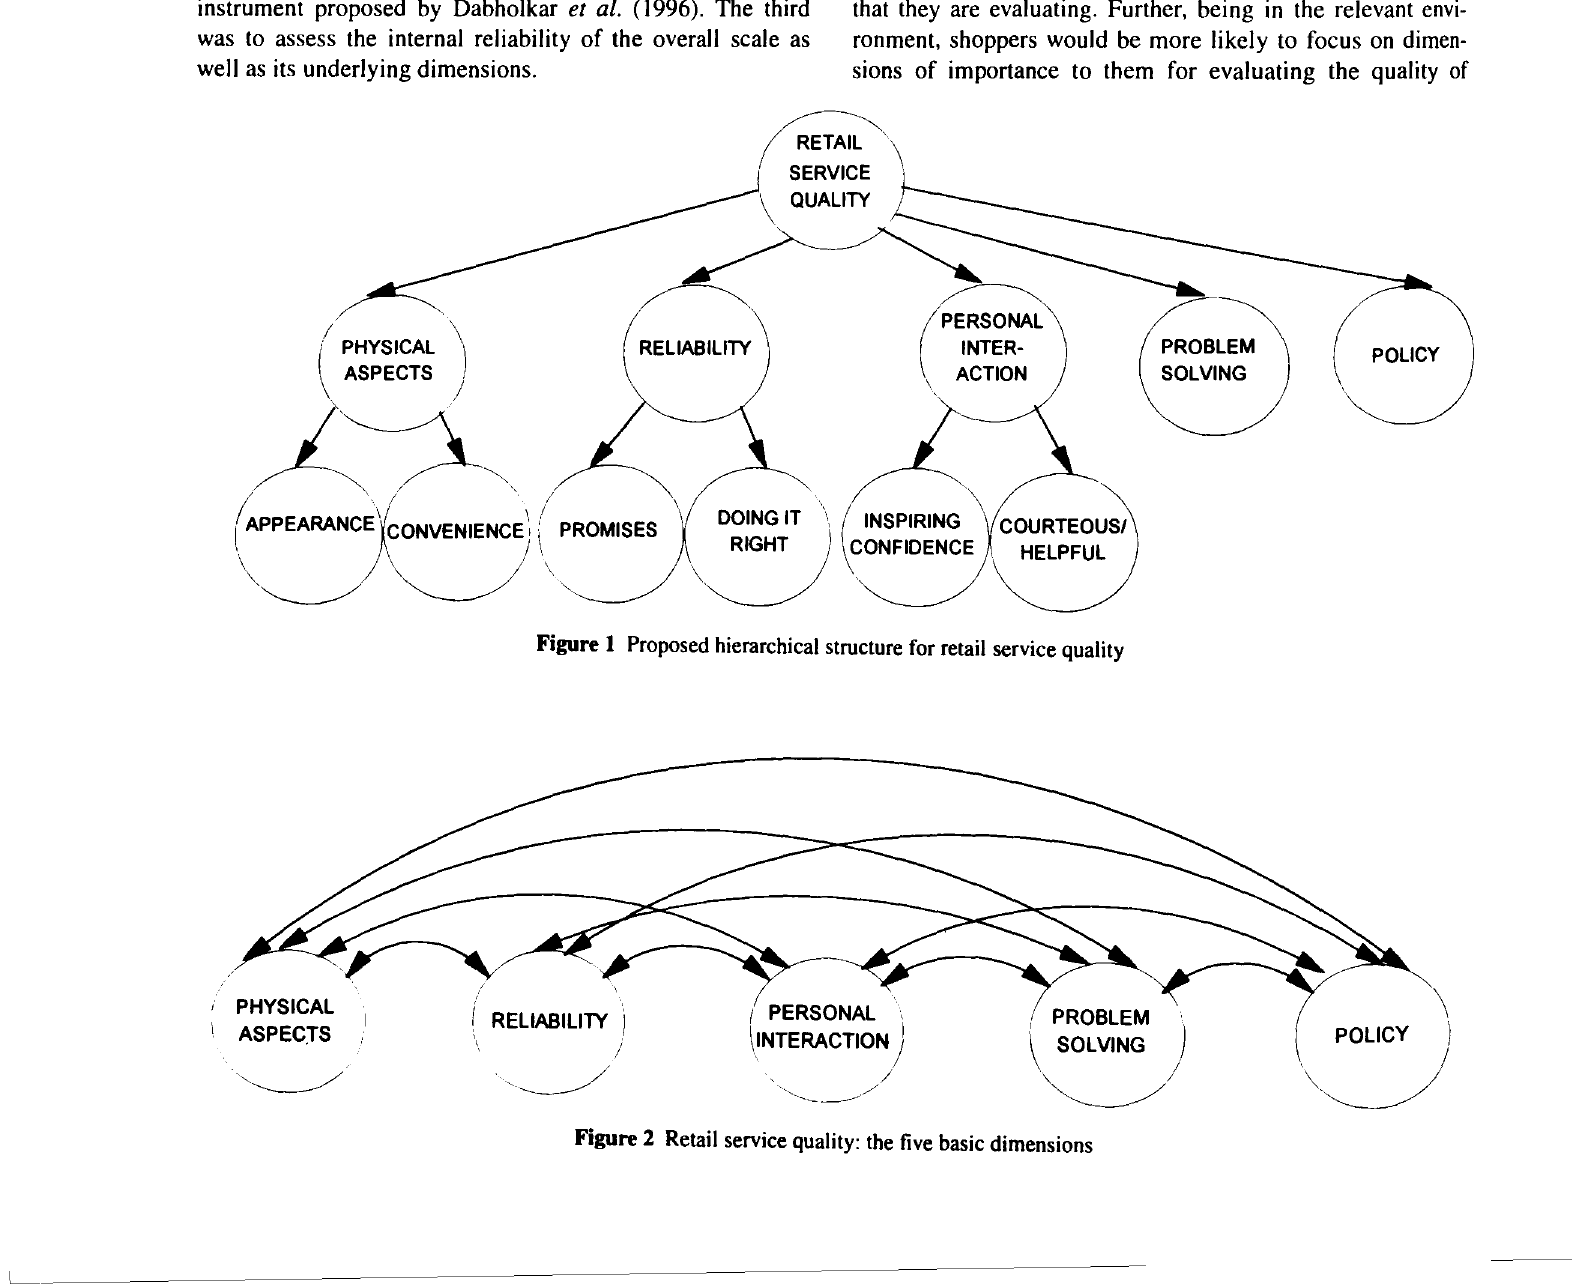
Figure 2 Retail service quality: the five basic